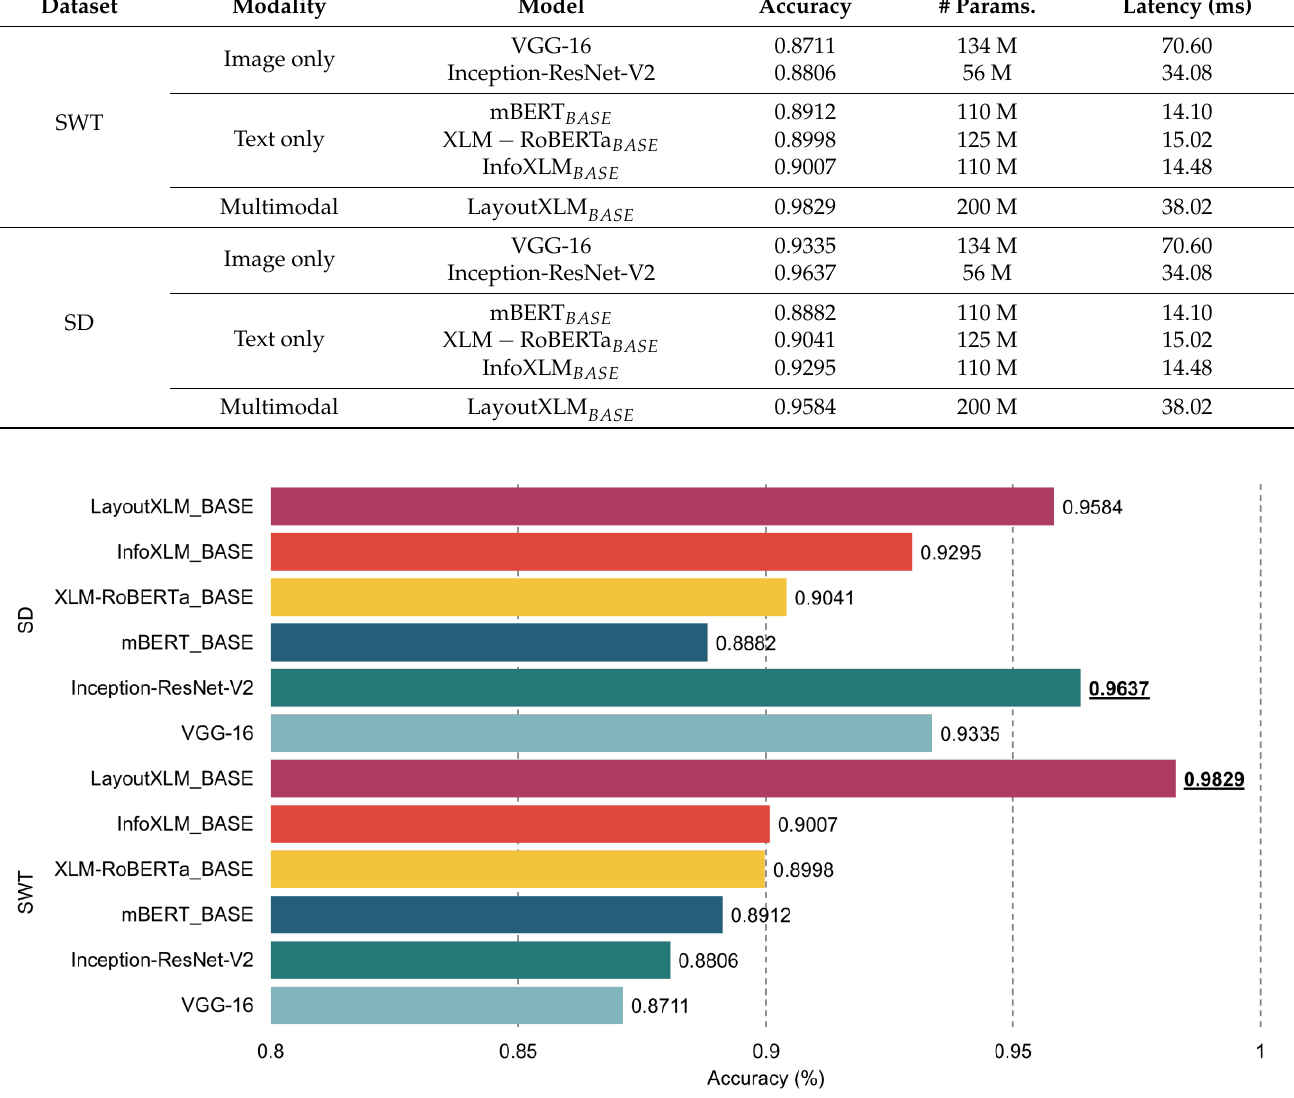
Figure 6. Performance comparison for accuracy. The values indicated in bold and underlined represent the best performance. Table 4. Performance of document classification.